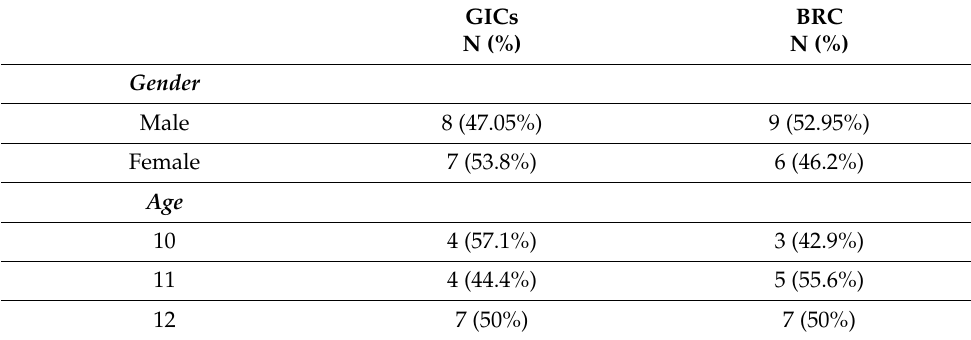
Table 3. Demographic characteristics of patients with GICs and BRC